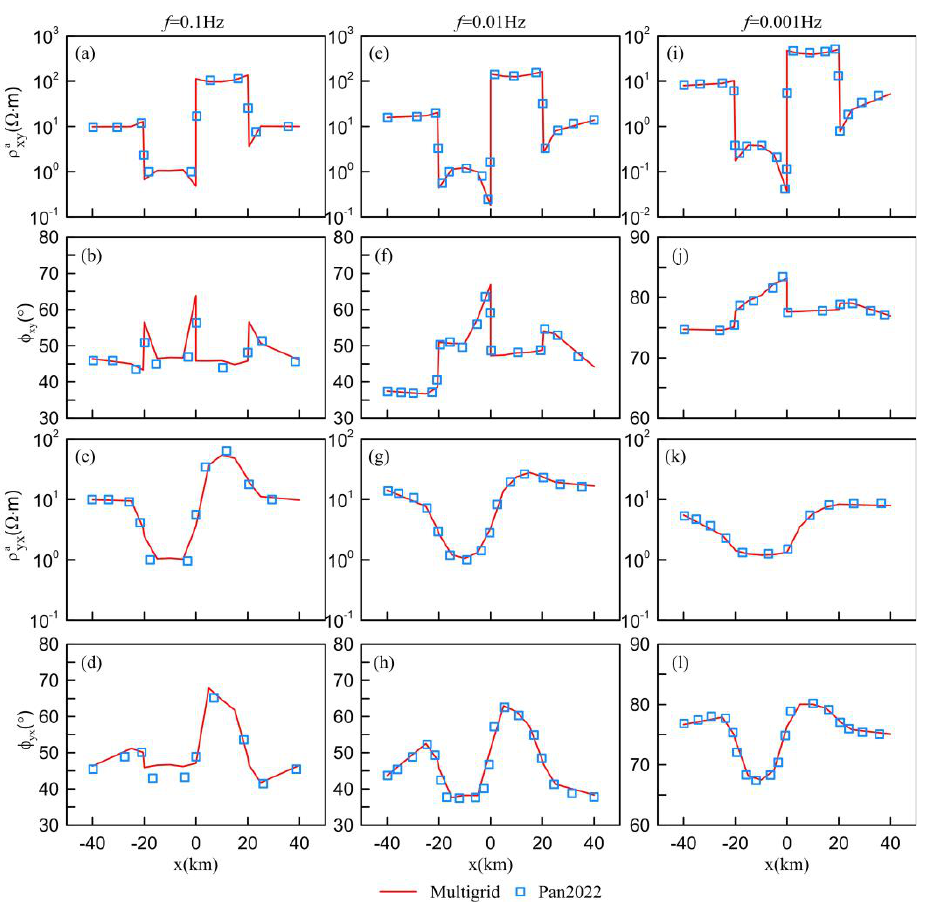
Figure 7. Apparent resistivities and phases calculated for the COMMEMI3D-2 model at frequencies of 0.1, 0.01, and 0.001 Hz for the survey line y = 0. ( a , e , i ) and ( b , f , j ) are respectively the apparent resistivities and phases for the frequencies of 0.1, 0.01, 0.001hz in x -polarization mode, while ( c , g , k ) and ( d , h , l ) are respectively the apparent resistivities and phases for the same frequencies in the y -polarization mode. The red lines represent the MG results, while the blue squares represent the results from Pan et al. [44] . Table 1. Computational performance of SOR-GMRES, ILU-BICGSTAB, SOR-BICGSTAB, and